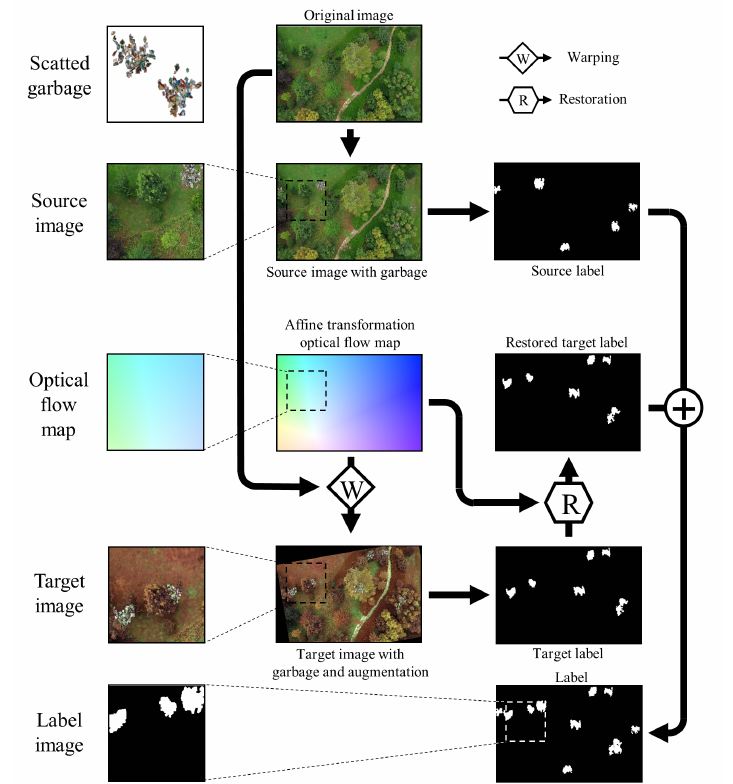
Figure 7. The procedure of dataset